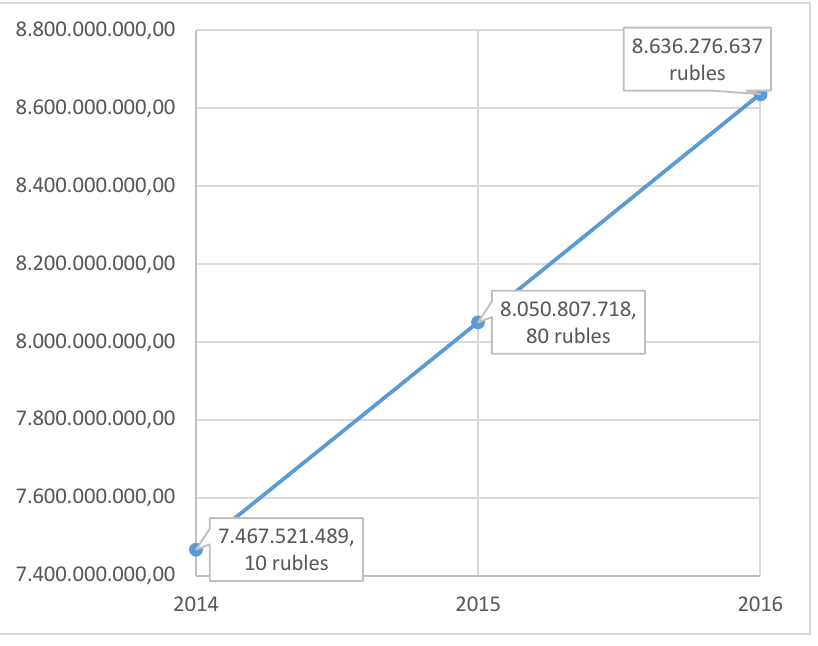
Fig. 1. The volume of paid services for the population from 2014 to